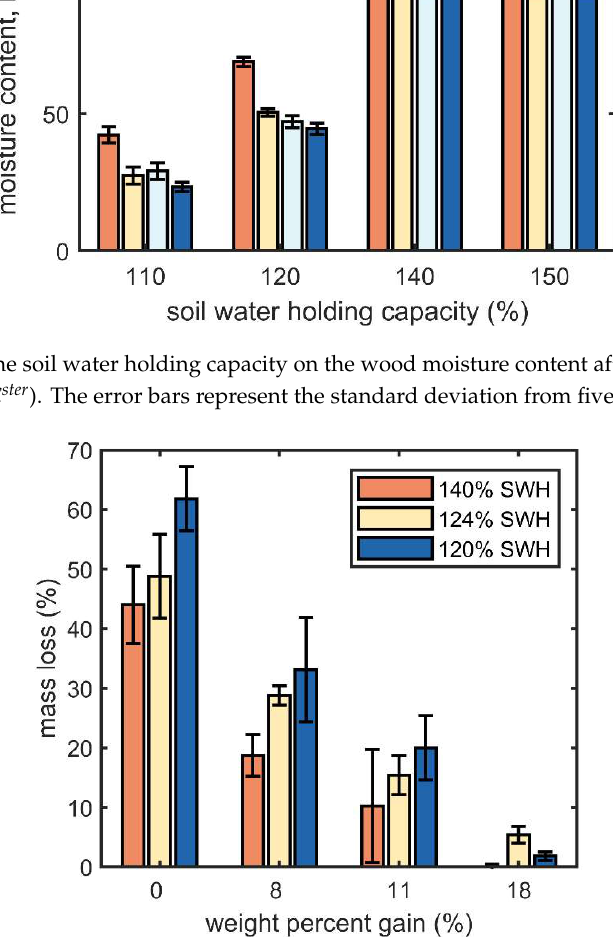
Figure 3. Effect of the soil water holding capacity on the wood moisture content after 8 weeks with no fungus present ( 𝑀𝐶 (cid:3046)(cid:3047)(cid:3032)(cid:3045) ). The error bars represent the standard deviation from five replicates.